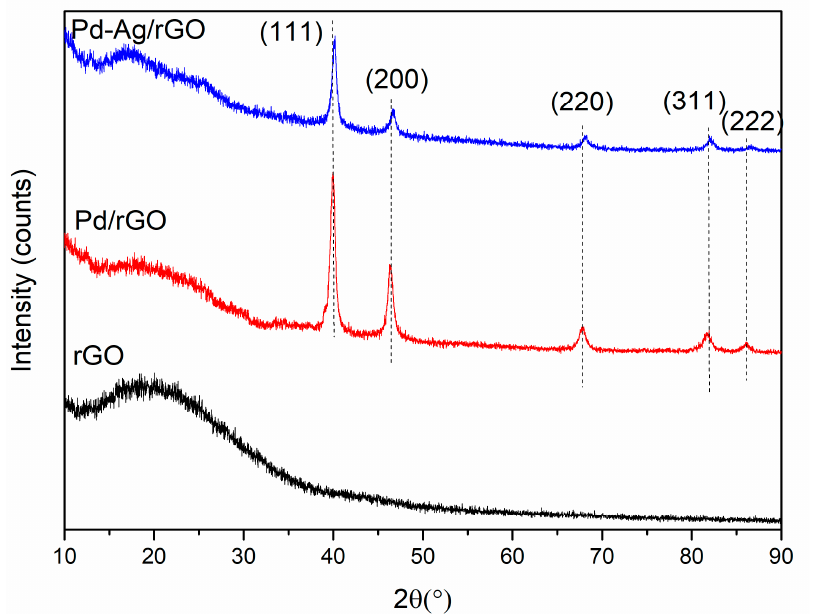
Figure 2. X-ray diffraction results of synthesized materials of rGO, Pd/rGO, and Pd-Ag/rGO nanostructures.